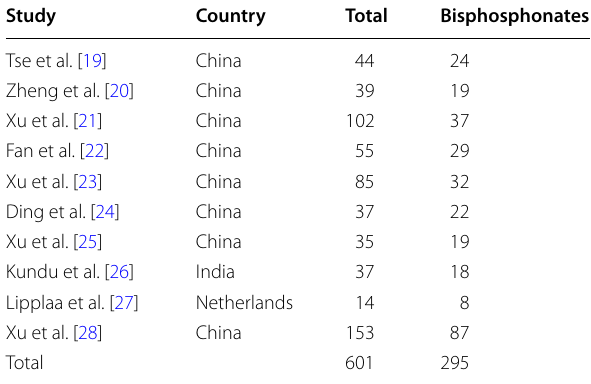
Table 2 Characteristics of the selected studies for the meta-